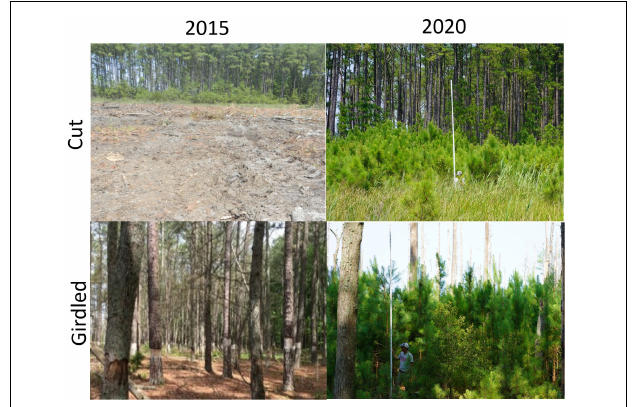
FIGURE 3 | Shows change at Moneystump Swamp transgression experiment (Cambridge, MD, United States) from clear-cut state immediately after tree cutting (top left, photo credit: Patrick Brennand) to tree regrowth after 5 years post-recovery (top right, photo credit: David C. Walters) and change from standing dead pines immediately after girdling (bottom left, photo credit: Patrick Brennand) to tree regrowth amongst standing dead trunks after 5 years post-recovery (bottom right, photo credit: David C. Walters). 2020 photos include a 5 m staff positioned at the first row of live pines for